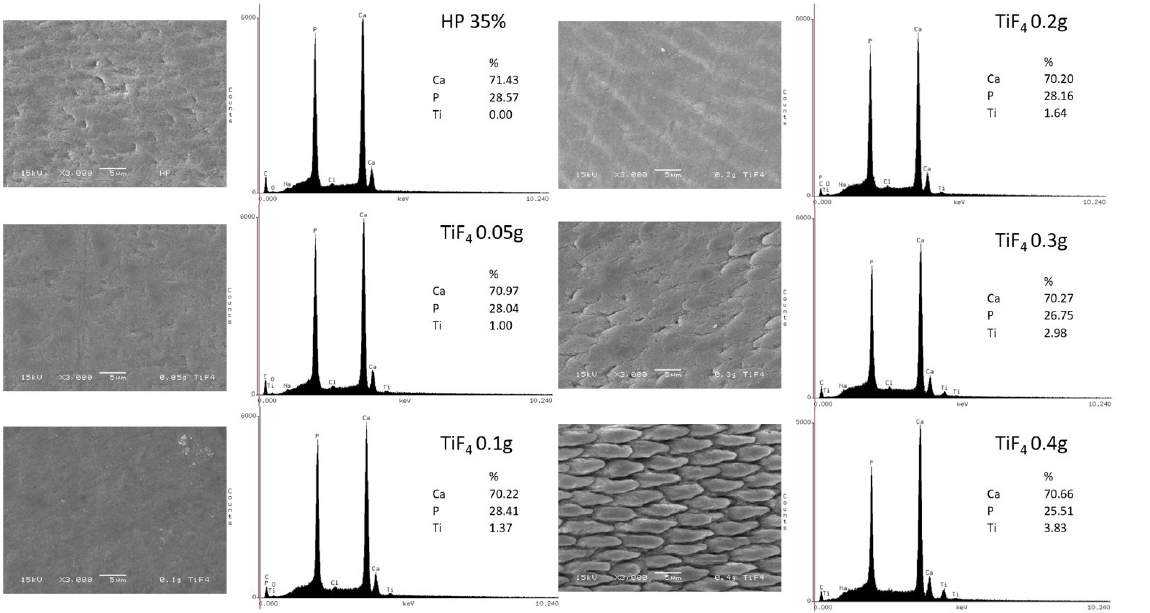
Figure 4. Enamel surface morphology after bleaching treatment of each group by SEM (3000 × magnifi- cation) and EDS analysis. Legend: Ca: calcium; P: phosphorus; Ti: titanium; TiF 4 : titanium